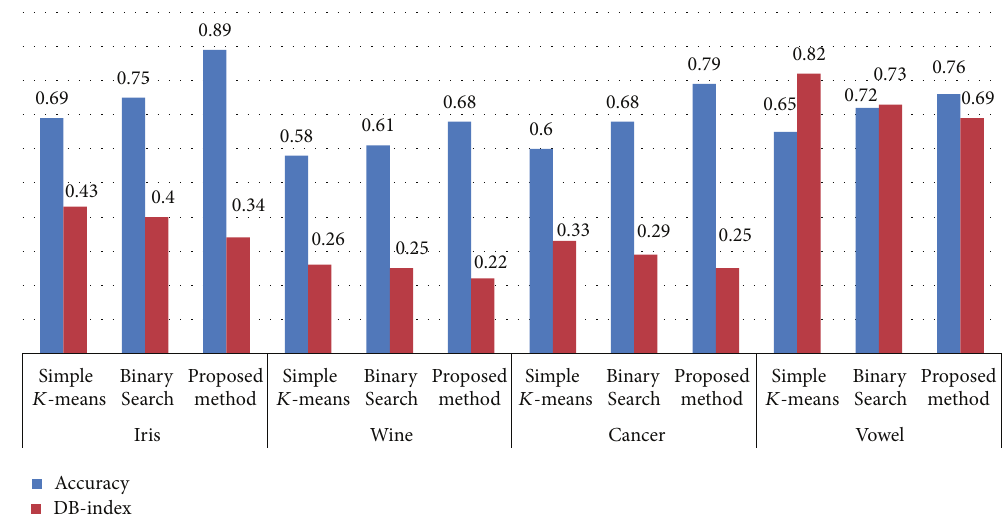
Figure 6: Comparative analysis of the algorithms based on accuracy and DB